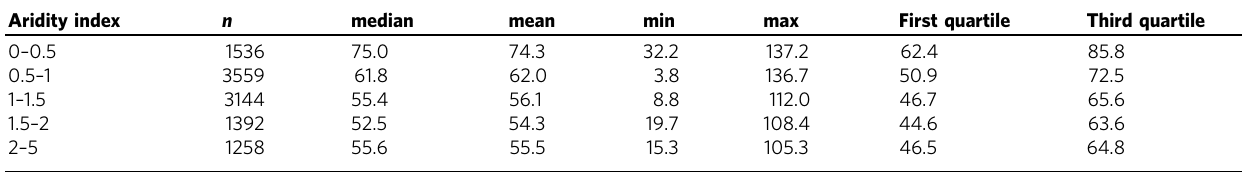
The number of observations ( n ) is shown as are distribution parameters (median, mean, minimum and maximum and lower and upper quartiles). AI<1 indicates water-limited conditions. We excluded 32 observations for AI>5.